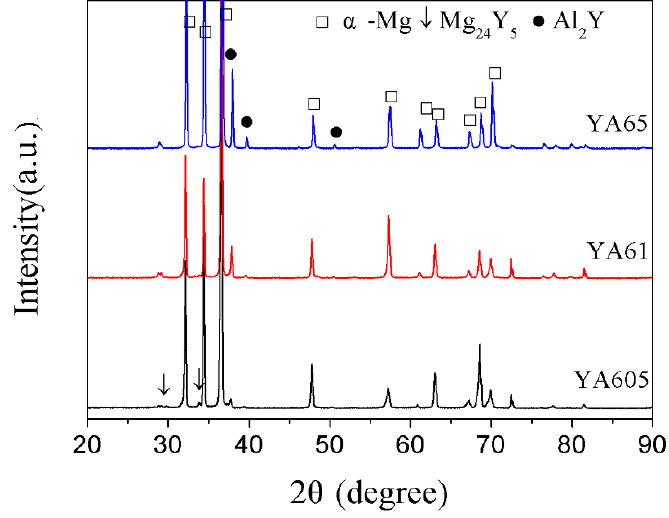
Figure 2. XRD patterns of the as-cast alloys.